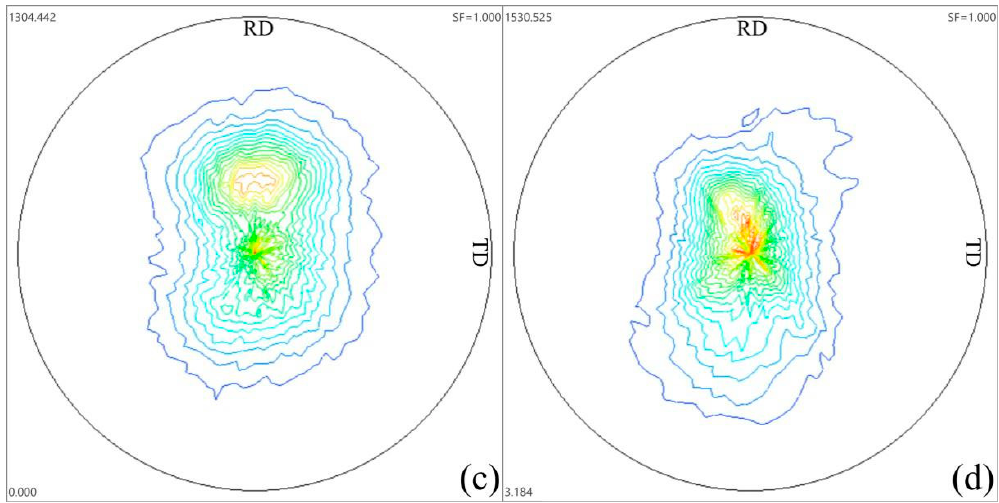
Figure 7. Pole figure detected by XRD in AZ31 alloys HSRMFed to 6 pass with different pass strains ( a ) 0.1, ( b ) 0.16, ( c ) 0.22 and ( d ) 0.35.